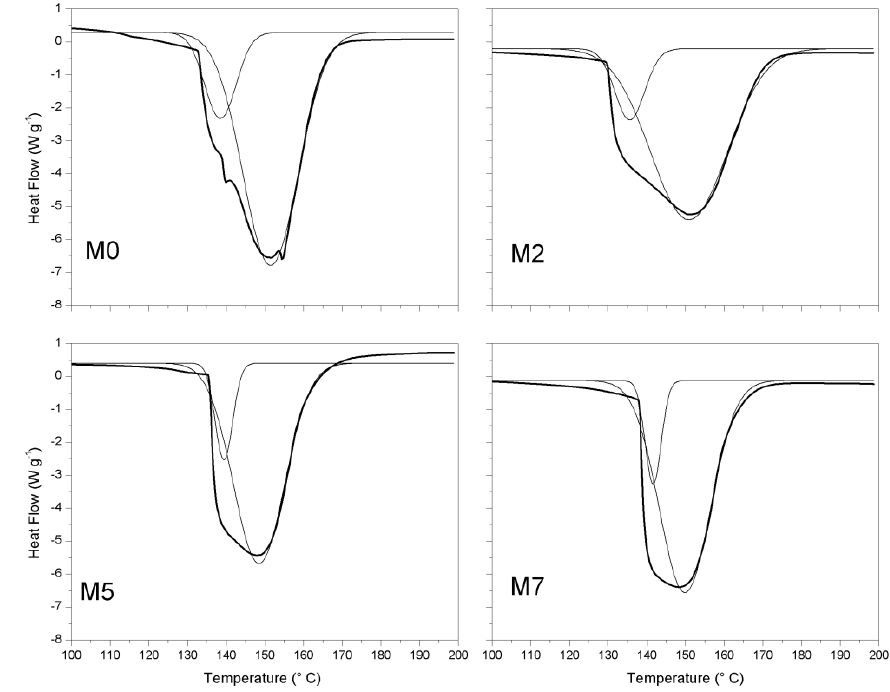
Figure 6. Differential scanning calorimetry (DSC) traces of the membranes samples (black line) and Lorenztian functions utilized to fit them (gray line).